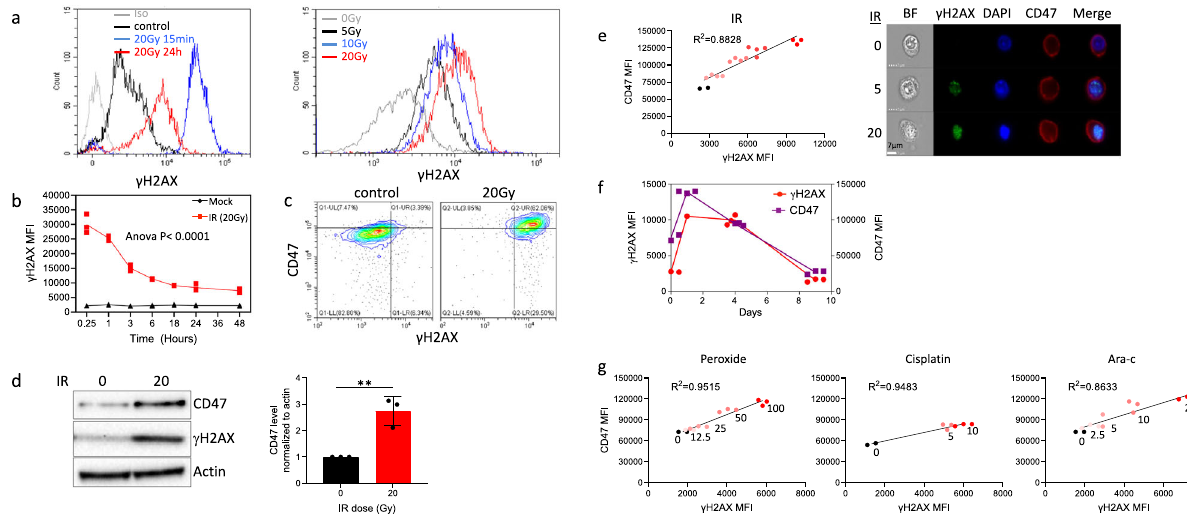
Fig. 3 CD47 expression correlates with the level of γ H2AX in response to treatment with genotoxic agents. a Representative histograms of γ H2AX staining before and after γ -irradiation. b Time-dependent expression of γ H2AX (MFI) following γ -irradiation (20 Gy). c Representative dot plot of γ H2AX and CD47 co-staining before and after γ -irradiation. d Cells were treated as above and after 24 h lysed. Western blot analyses were performed on whole cell extracts using antibodies to CD47 and γ H2AX. Anti- β -actin immunoblotting revealed relative amounts of protein in each lane. Graph on the right shows an average (±STD) level of CD47 expression in triplicate samples normalized to actin in each sample (right panels). e The level of CD47 expression in response to γ -irradiation correlates with the level of residual γ H2AX (left panel), and representative pictures taken by ImageStream of cells co-stained for CD47 and γ H2AX before (0) and after γ -irradiation (5 and 20 Gy). f Graph depicts CD47 expression and γ H2AX level (MFI) in HEK-293T cells 1,4 and 9 days after γ -irradiation. g The level of CD47 expression in response to different genotoxic agents correlates with the level of residual γ H2AX. Graph shows an average (±STD) of four replicates in each group. One of at least three independent experiments is